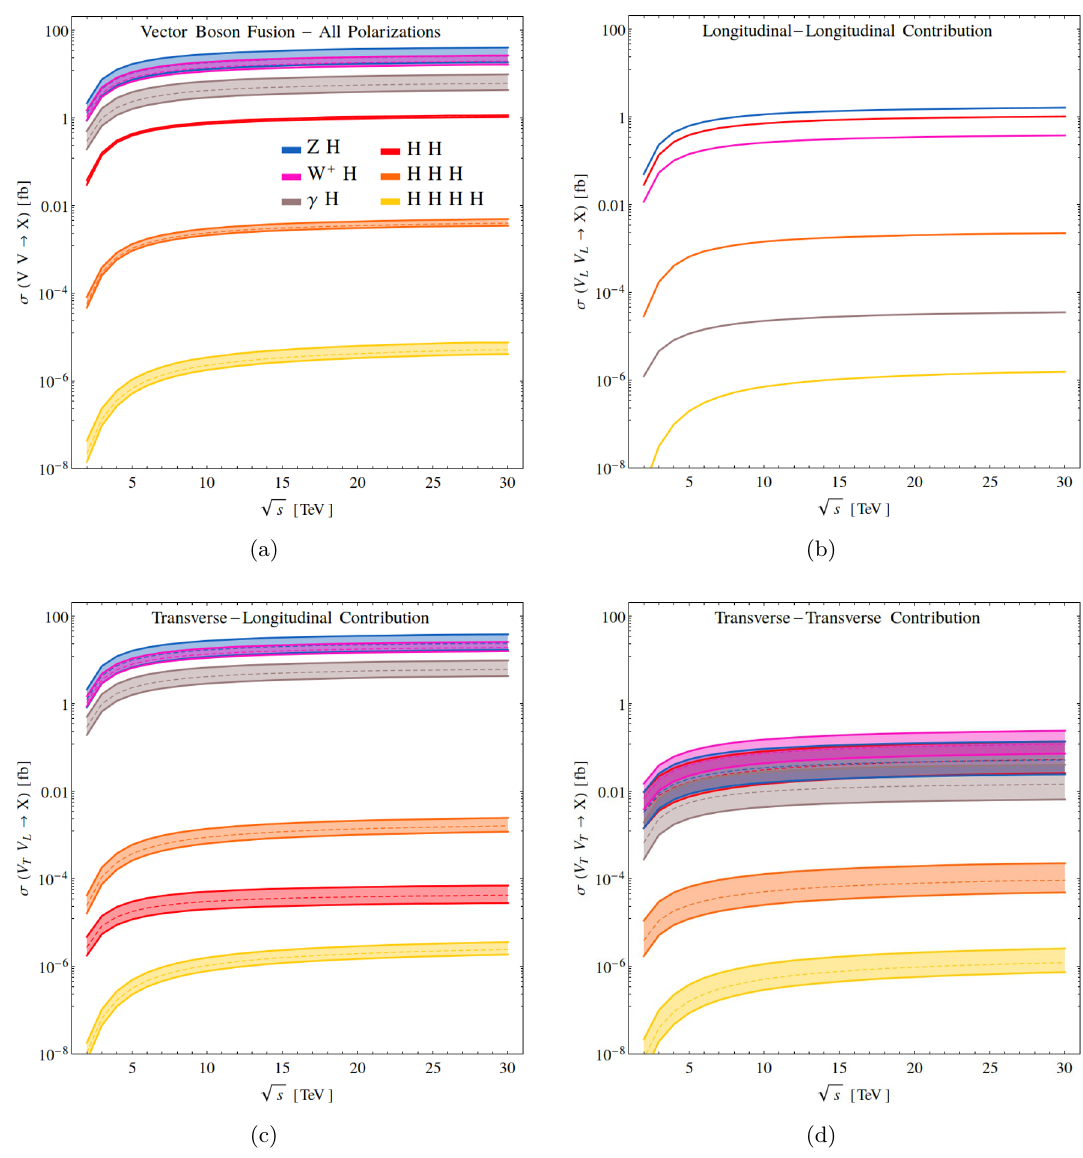
Figure 7 . As a function of collider energy, the fiducial cross section and scale uncertainties under the EVA for associated Higgs and multi-Higgs production in µ + µ − collisions from (a) all initial-state EW boson polarizations, (b) longitudinal-longitudinal scattering, (c) transverse-longitudinal scattering, and (d) transverse-transverse